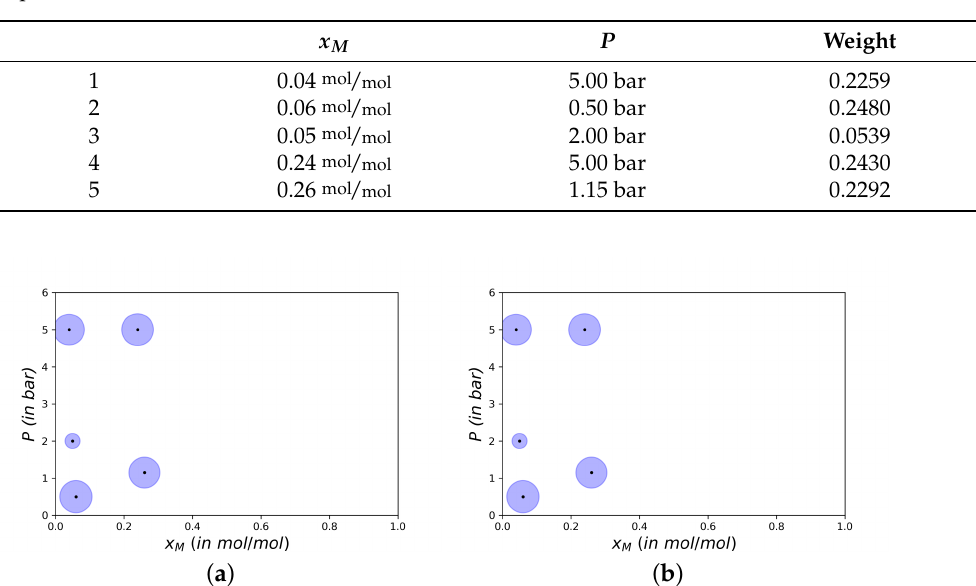
Table 2. Optimal design ξ YBT computed with the YBT algorithm for the flash with a methanol-water input feed.